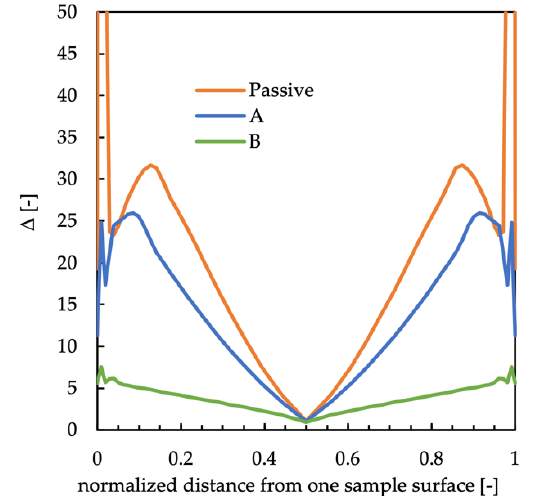
Figure 12. Distributions of the stretch, ∆ , calculated by the simulation at the end of the process for the passive case and for cases A and B.